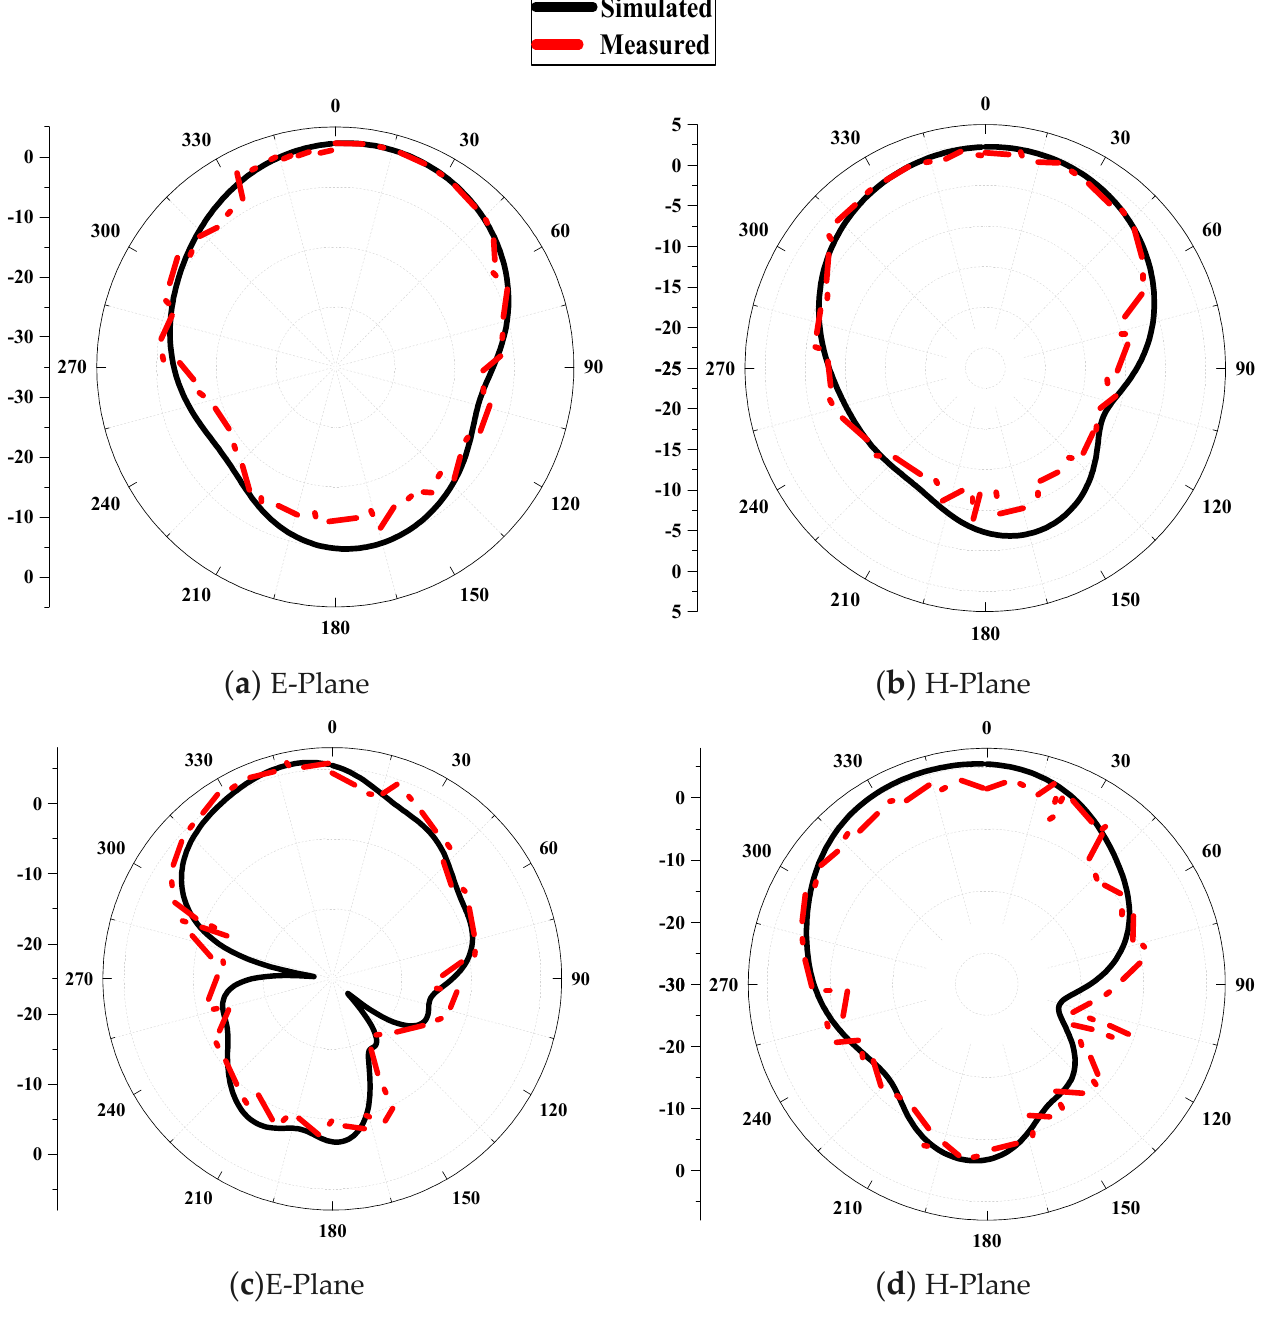
Figure 28. Simulated and measured 2D radiation patterns of the AMC-backed antenna on a watch plus human tissue: ( a ) at 2.45 GHz (E plane); ( b ) at 2.45 GHz (H plane); ( c ) at 5.8 GHz (E plane); ( d ) at 5.8 GHz (H plane). Table 5. Comparison of this work with previous research.